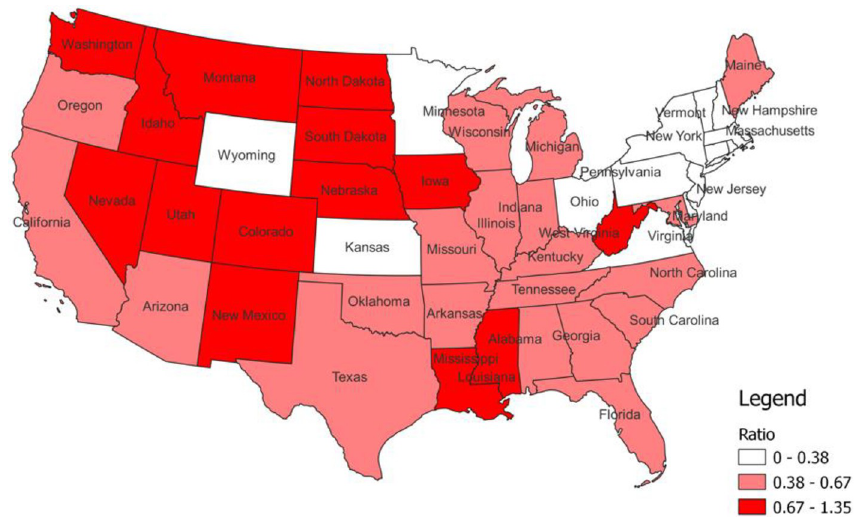
Fig 1. Choropleth map of the ratio of a call being from a veterinarian compared to the public in each state.